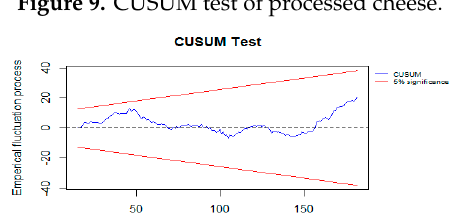
Figure 9. CUSUM test of processed cheese.